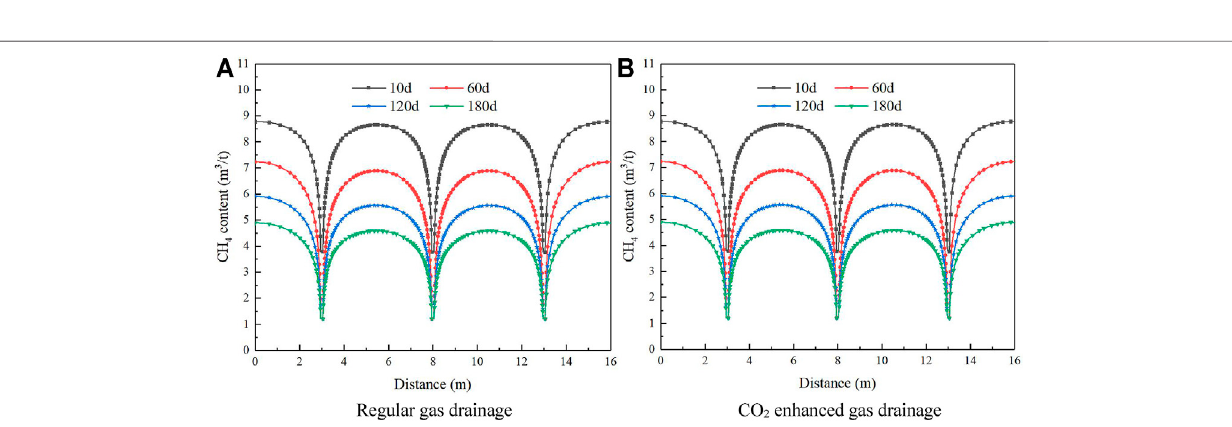
Frontiers in Earth Science |